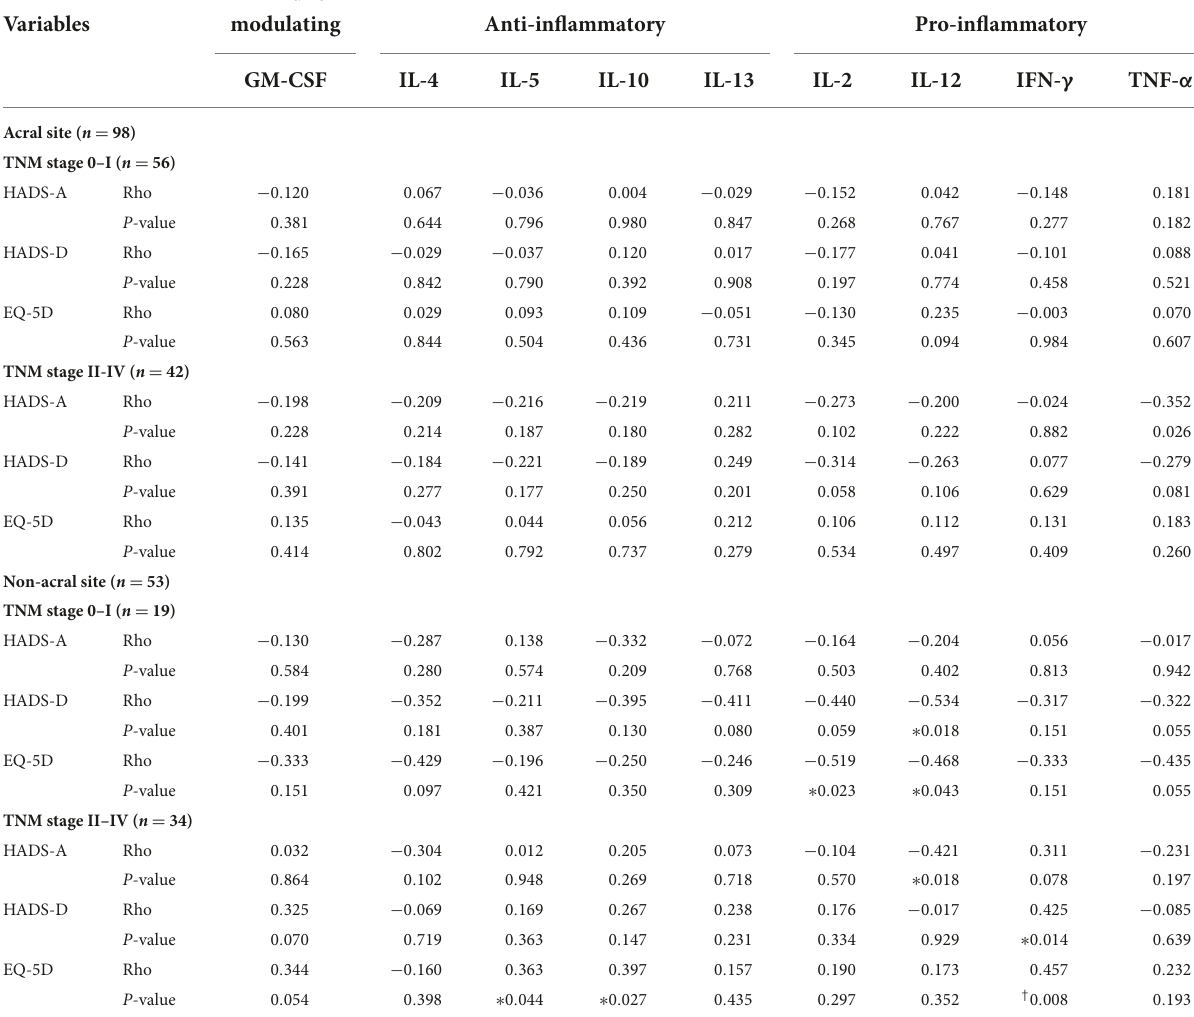
TABLE 3 Correlations of anxiety, depression, and QOL with cytokine levels by acral and non-acral melanoma TNM